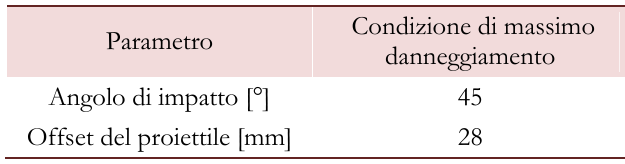
Tabella 2: Condizioni di impatto.